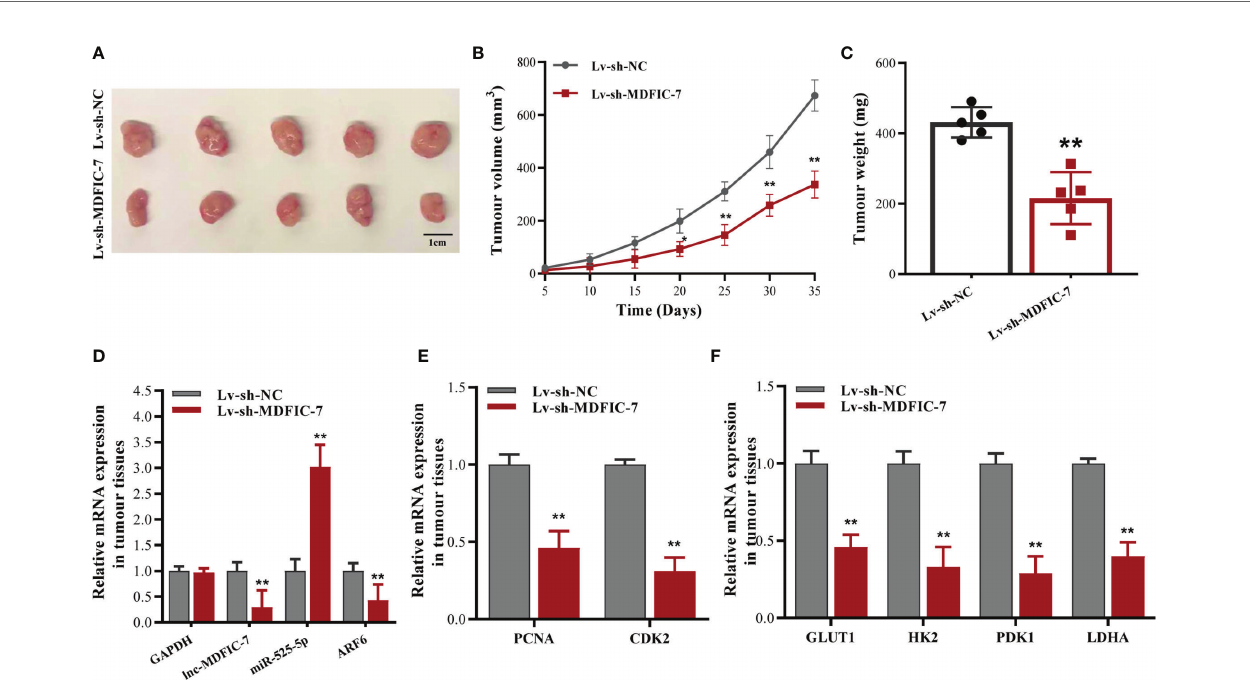
FIGURE 7 | Inhibition of lncRNA MDFIC-7 expression suppresses chordoma cell growth and aerobic glycolysis gene expression in vivo . (A) Representative images of tumor xenografts collected from lncRNA MDFIC-7 knockdown (Lv-sh-MDFIC-7) and control (Lv-sh-NC) groups. The tumor volumes were calculated every 5 days after cell inoculation. (B) Growth curve of tumor xenografts measured every 5 days. (C) Weights of tumor xenografts in the Lv-sh-MDFIC-7 and Lv-sh-NC groups. (D) qRT-PCR analysis of lncRNA MDFIC-7, miR-525-5p and ARF6 mRNA in the xenograft tumor tissues. (E) qRT-PCR analysis of PCNA and CDK2 mRNAs in the xenograft tumor tissues. (F) qRT-PCR analysis on mRNAs of GLUT1, HK2, PDK1 and LDHA in the xenograft tumor tissues. ** p <